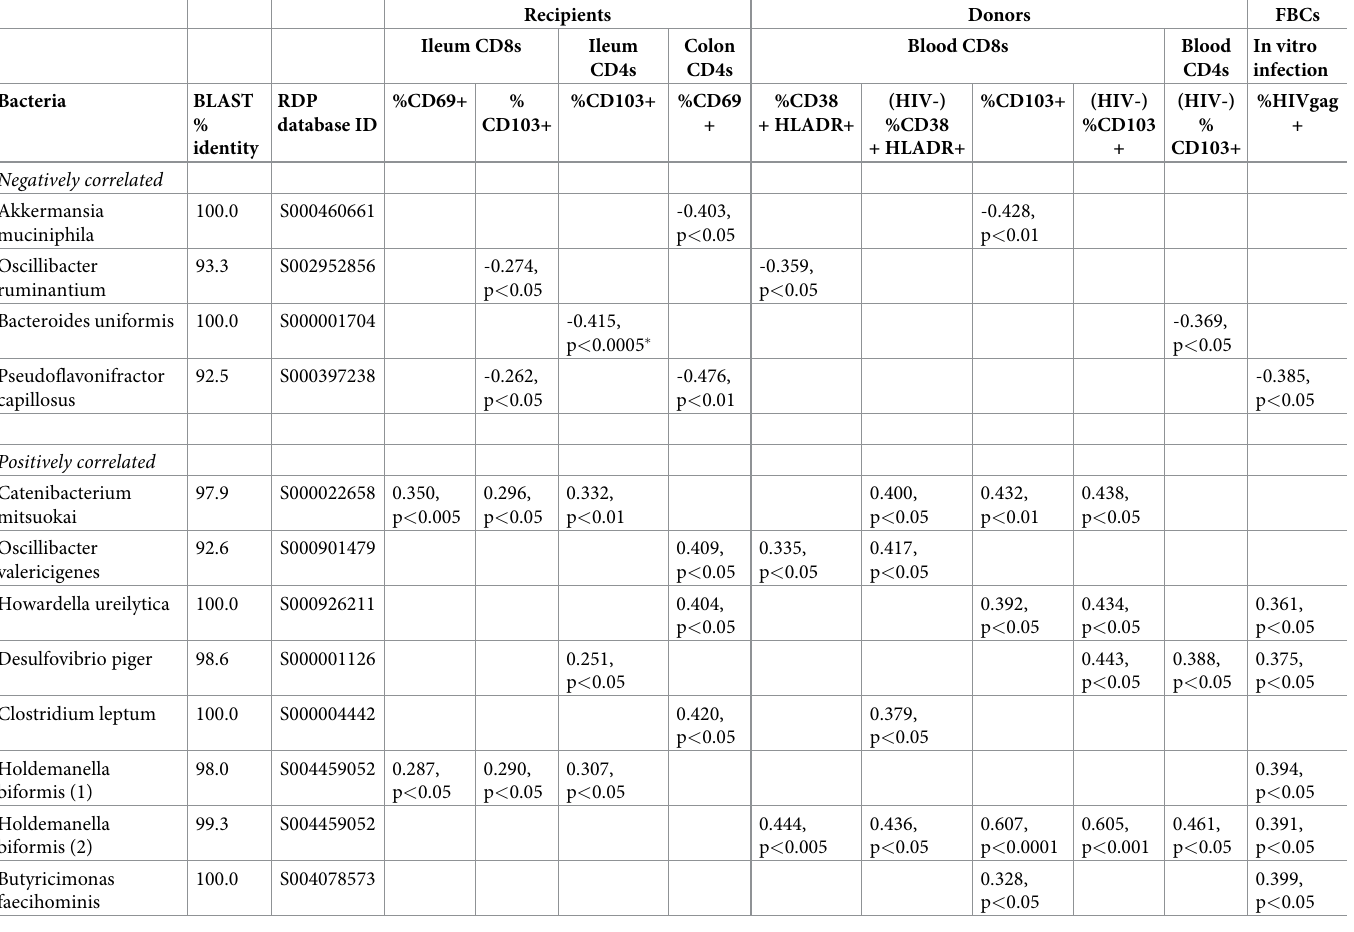
Table 1. Microbial correlates with donor/recipient T cell activation and gut homing, and in vitro HIV